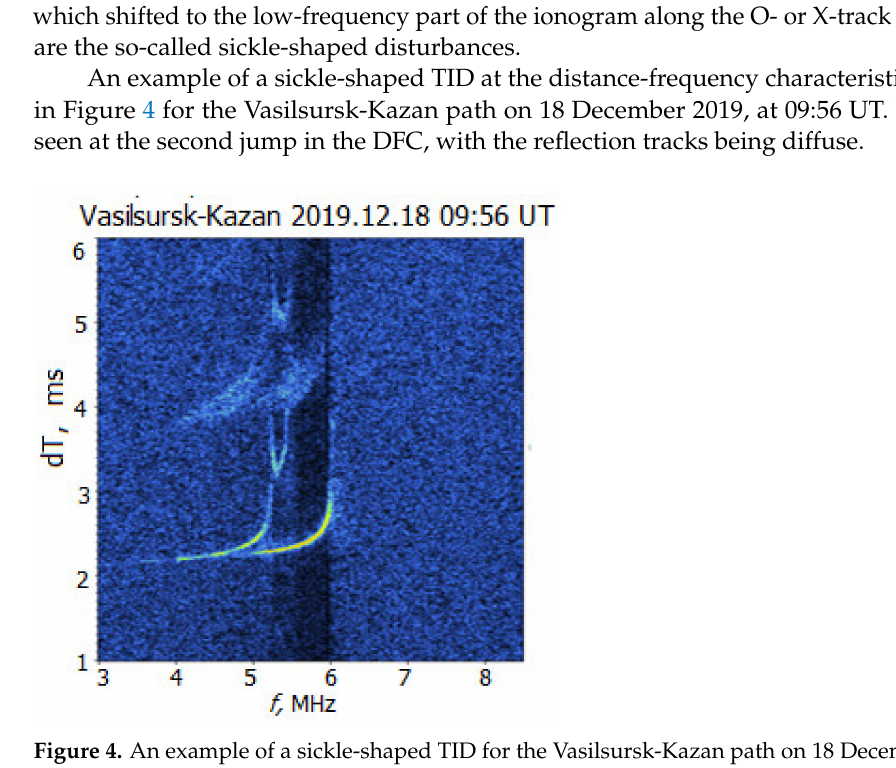
Figure 4. An example of a sickle-shaped TID for the Vasilsursk-Kazan path on 18 December 2019. Note that on 18 December 2019, from 09:13 to 09:17 UT, a TID was registered on the Yoshkar-Ola—Kazan path and was not recorded on the other paths. Considering the distance between the midpoints of the paths, it can be assumed that the specific horizontal dimensions of such ionospheric disturbance did not exceed 100